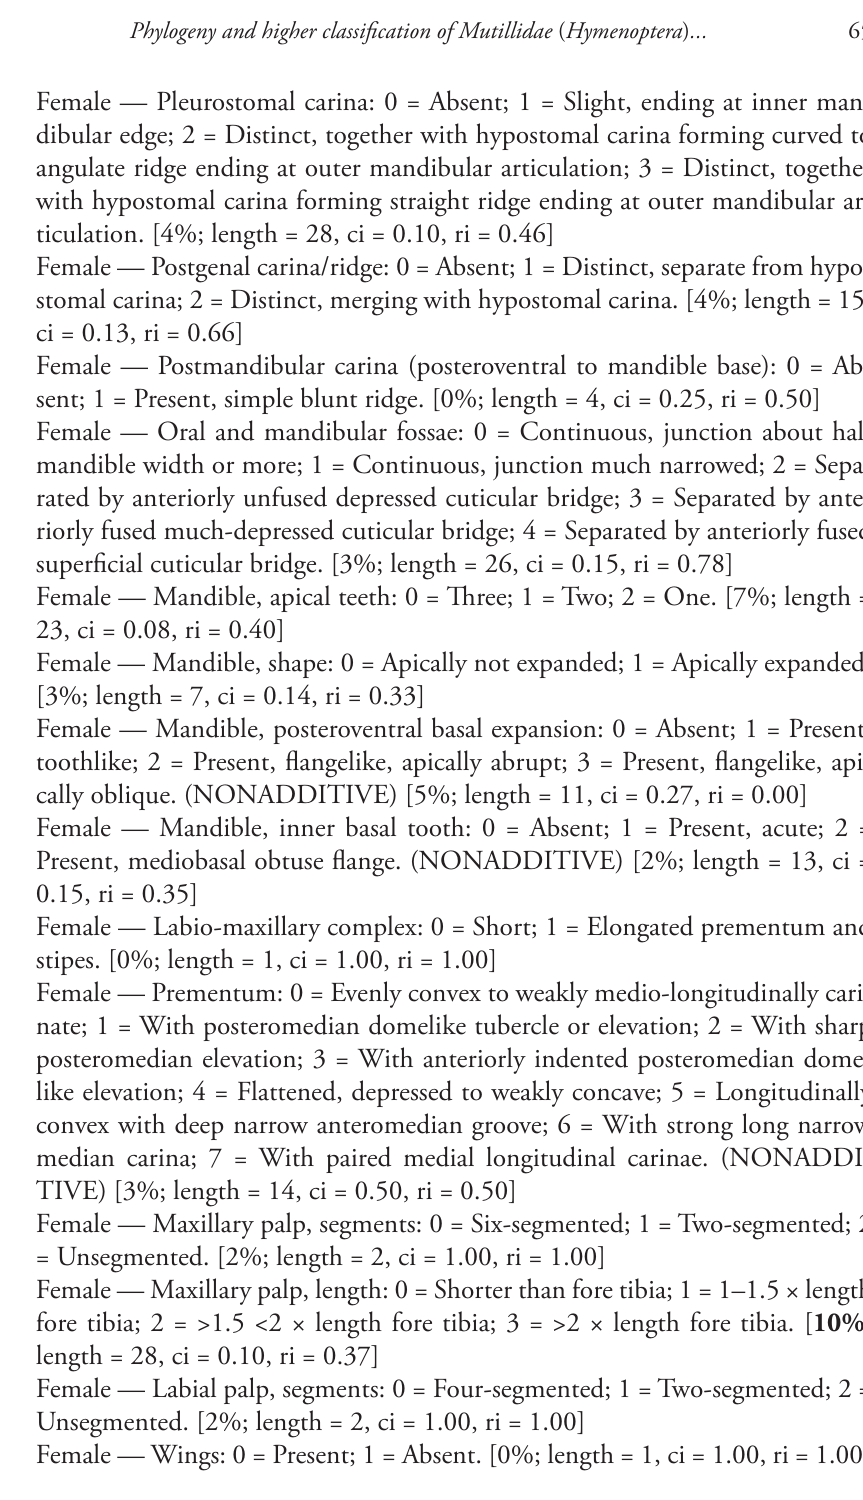
dibular edge; 2 = Distinct, together with hypostomal carina forming curved